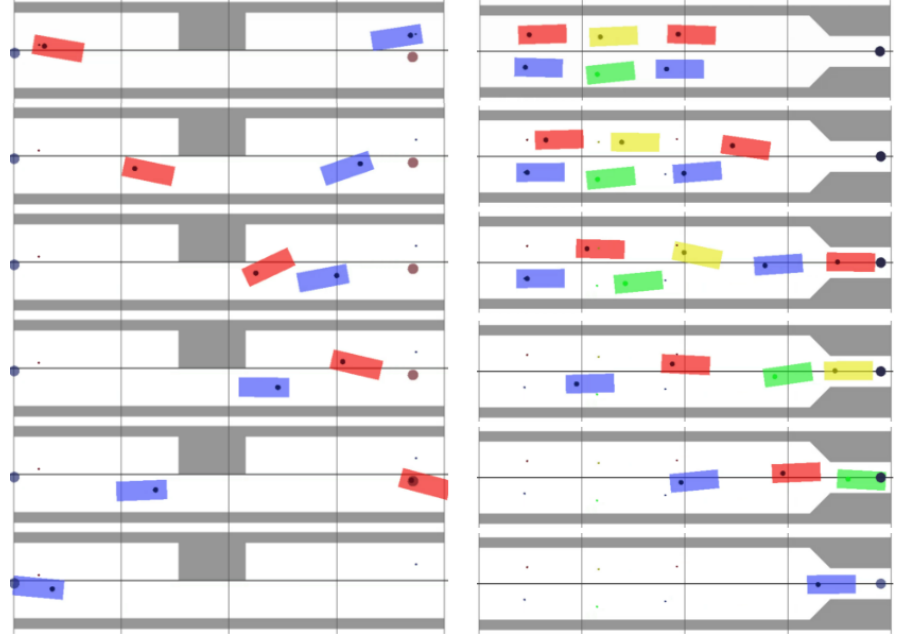
Figure 8. Evolution of the episodes for the bottleneck and zipper